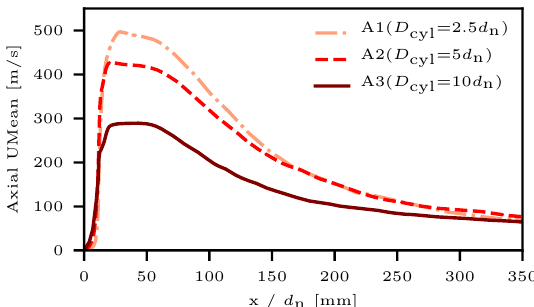
Figure 5. Axial centerline streamwise component of the mean velocity, circumferentially averaged along the axial centerline within a radial distance of ∆ = 62.5